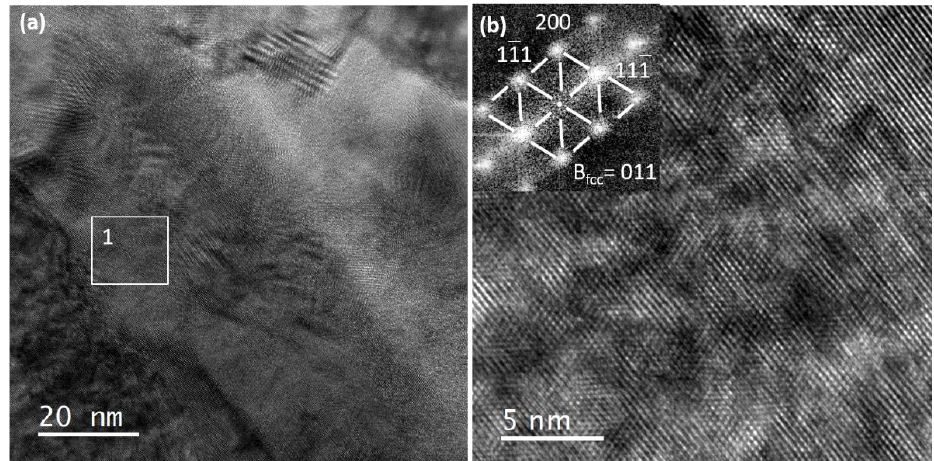
Figure 4. High-resolution TEM of the interface region: ( a ) bright-field TEM of the interface phase, ( b ) high-resolution image of the interface phase with corresponding Fast Fourier Transform (F.F.T.).